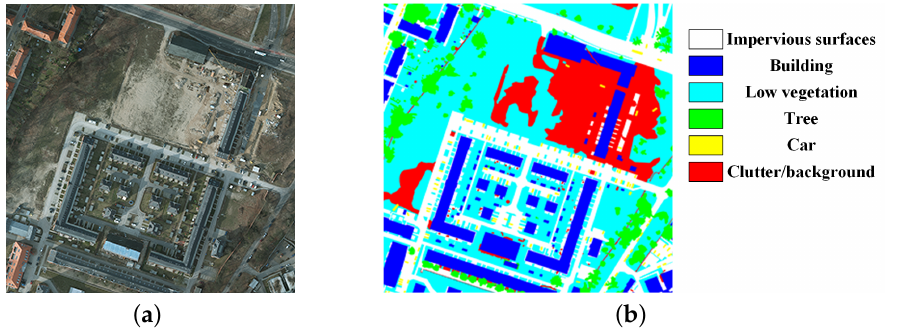
Figure 5. Potsdam-B data presentation; ( a ) original image; ( b ) label